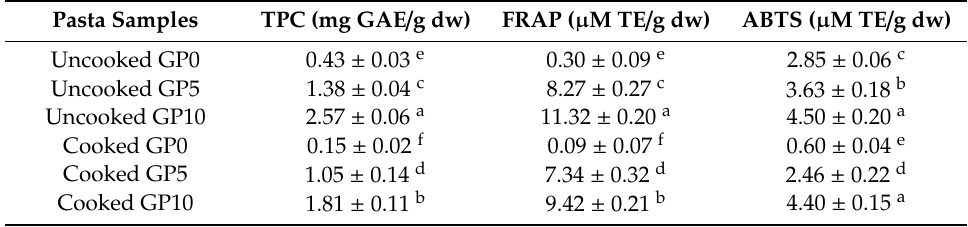
Table 3. Total phenolic component (TPC) and antioxidant activity (FRAP and ABTS) of cooked and uncooked control pasta (GP0) and pasta fortified with di ff erent percentages of grape pomace (GP5 and GP10). The values are expressed as mean ± standard deviation.